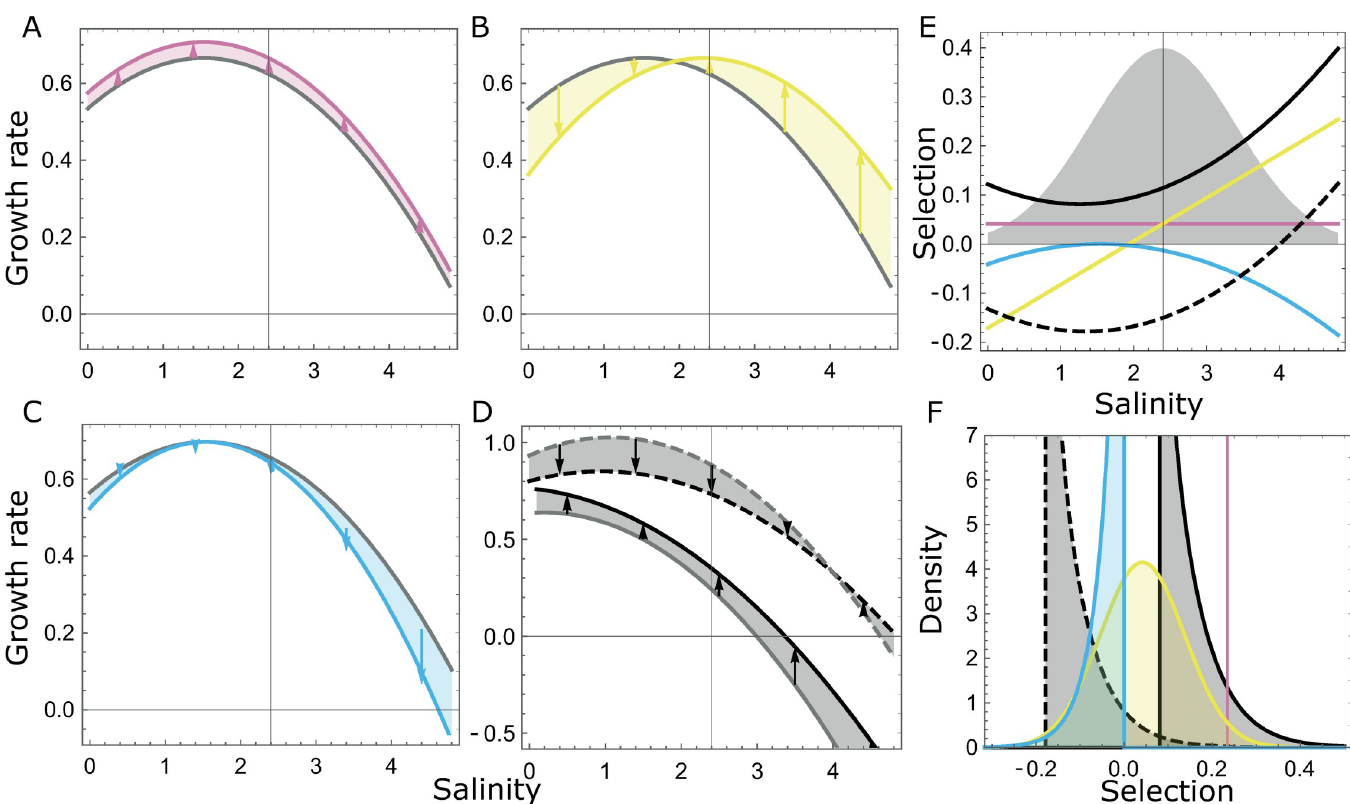
Fig 1. Relationship between tolerance curves and selection across environments. Panels a-d represent tolerance curves, with absolute fitness (population growth) in isolation plotted against the environment (here, salinity). In panels a, b and c, the tolerance curve of a reference strain (in gray) is contrasted to that of an alternative genotype or mutant (in color), which varies in only one parameter of the tolerance curve: maximal growth (A), salinity optimum (B), or niche width/breadth (C). Selection for the mutant equals the difference in growth rates between strains (shown as arrows) if fitness is density- and frequency-independent. In addition, the past environment may influence the current tolerance curve of each strain, as illustrated in panel d, where the tolerance curve of the mutant (in black) and reference strain (in gray) vary depending on whether they were transferred from low (plain line, 0.5M) or high (dashed, 4M) salinity. Panel e shows the selection reaction norm for the mutant based on these tolerance curves (hence assuming density- and frequency-independent selection), using the same line types and colors as in panels a-d. The gray normal curve materializes the salinity distribution used in our fluctuating salinity experiment (rescaled vertically for graphical convenience). Panel f plots the resulting distribution of selection coefficients in the fluctuating environment, with line types and colors as in previous panels. Note that the distribution of selection coefficient is Gaussian if both strains have the same tolerance breadth (yellow), but can otherwise be highly skewed.